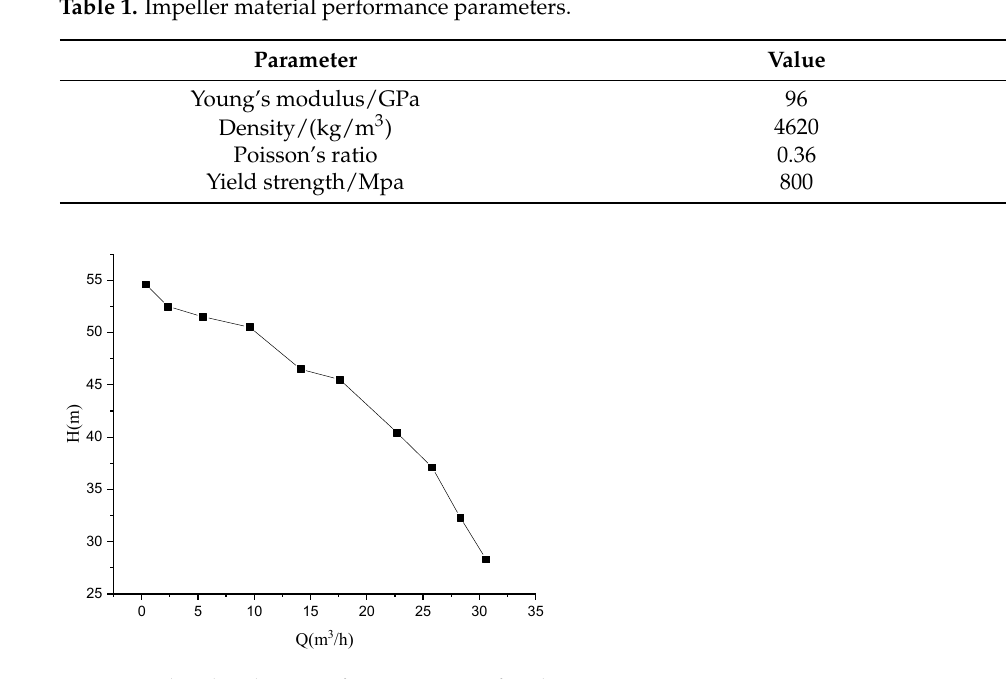
Figure 2. Flow head curve of Q25H52 centrifugal pump at 6400 rpm.